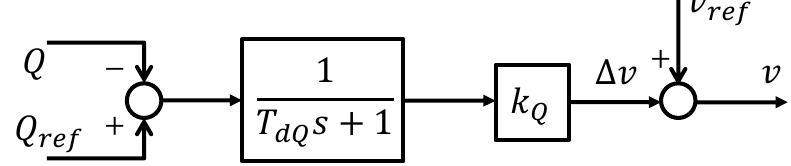
Figure 3. Reactive power–voltage control loop.